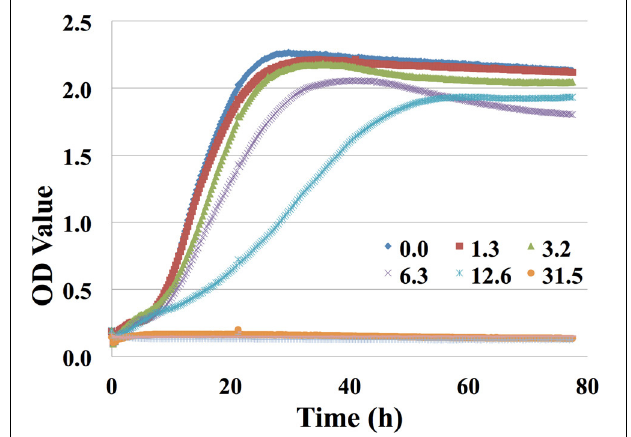
FIGURE 3 | Growth curves of C. necator in minimal medium with different concentrations (0, 1.3, 3.2, 6.3, 12.6, 31.5, 63, or 126mM) of furfural using Bioscreen C